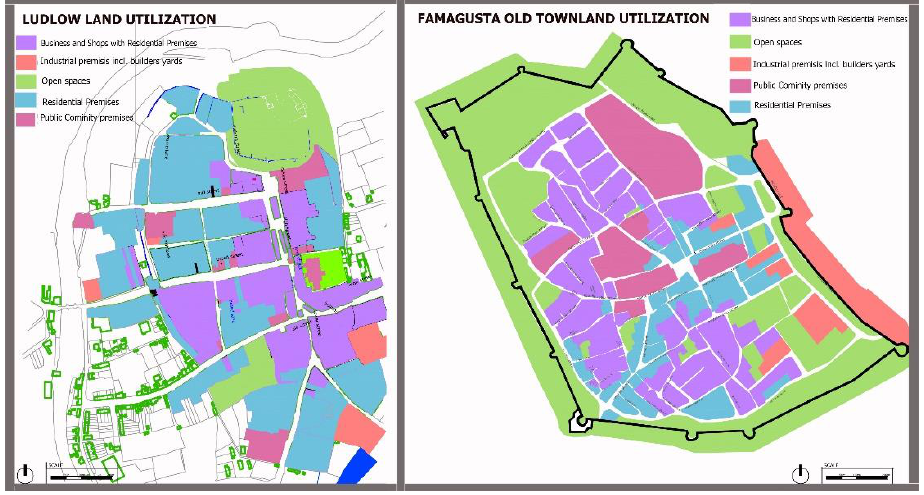
Figure 5 Ludlow and Famagusta Land